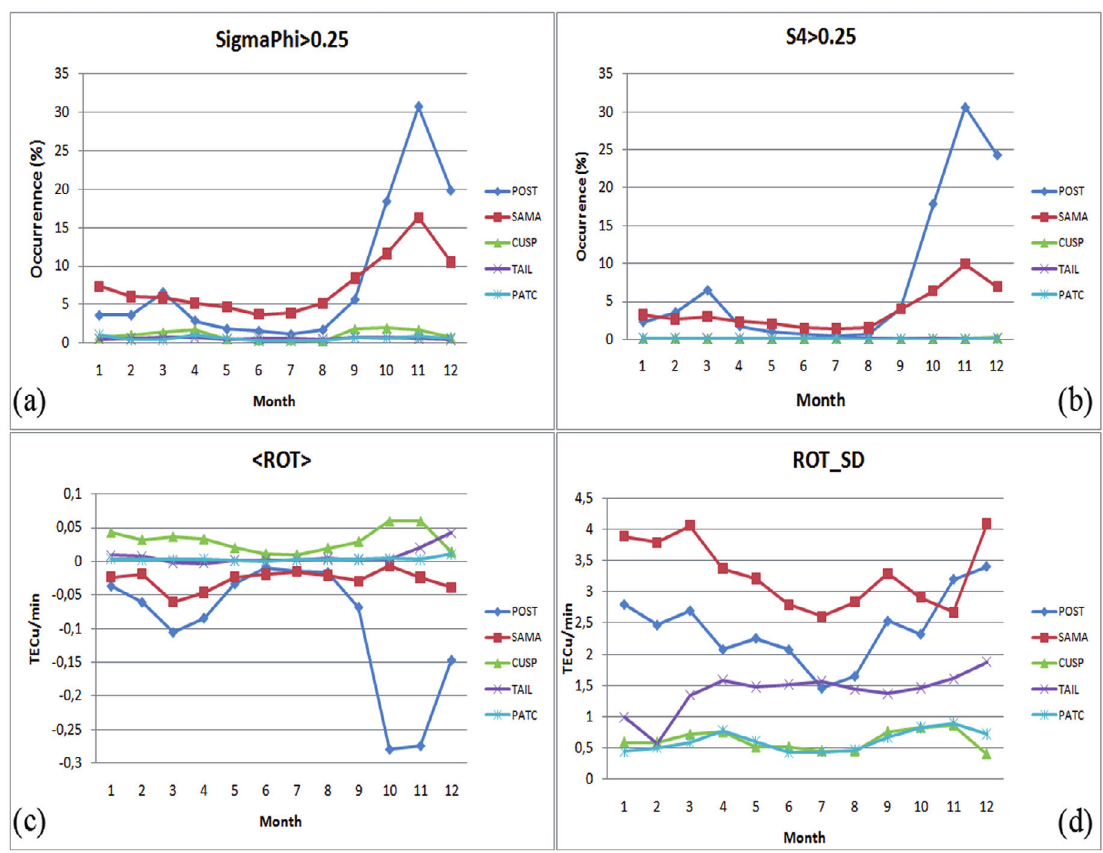
(b), and of the ROT mean 4